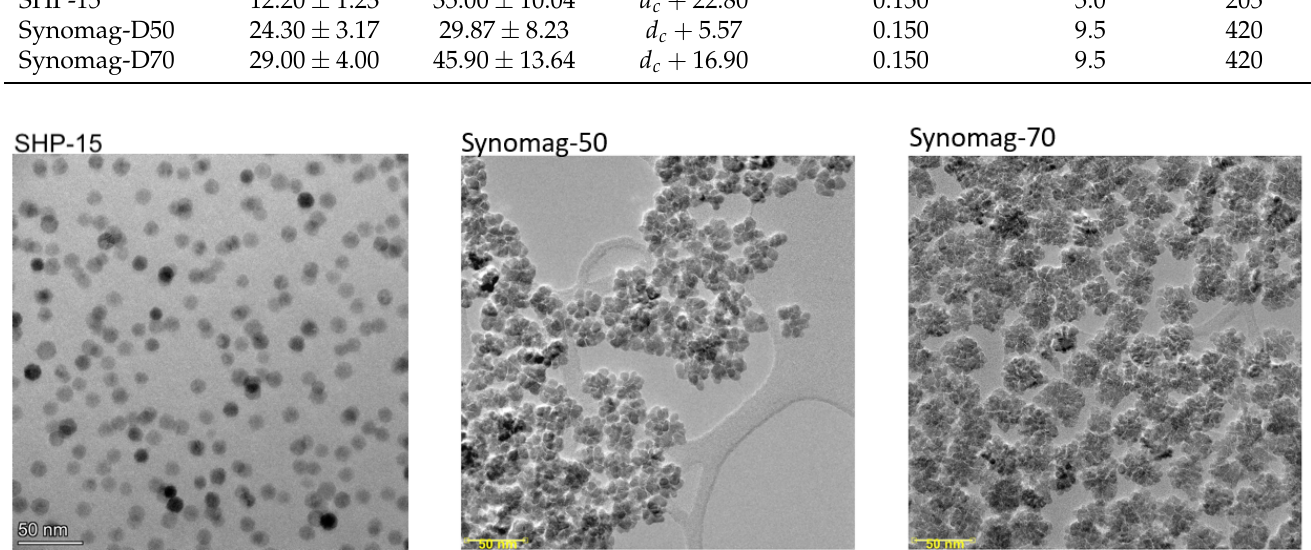
Figure 1. TEM micrographs acquired at an accelerating voltage of 300 kV: SHP-15 ( left ) was analysed using FEI Titan Cubed, Synomag-50 ( middle ) and Synomag-70 ( right ) were analysed using Philips